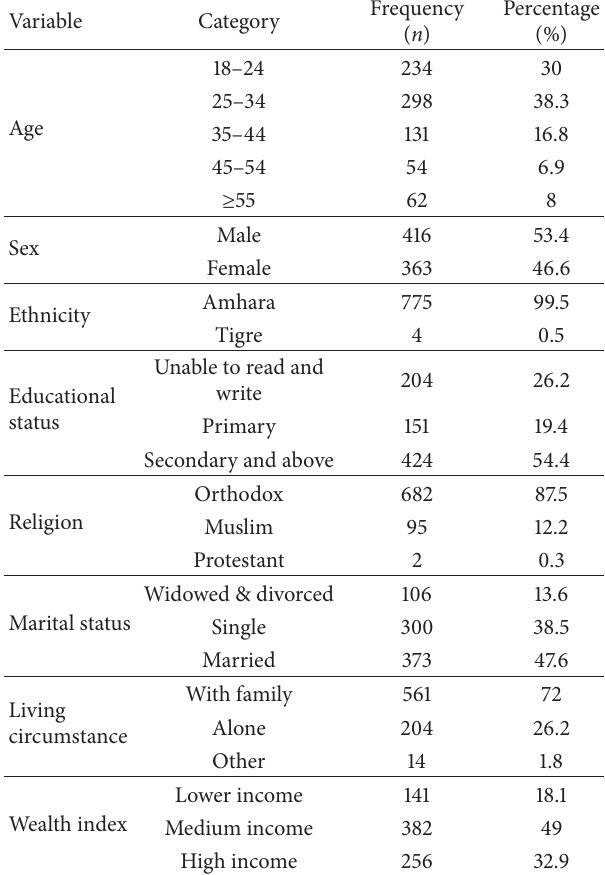
Table 1: Sociodemographic characteristics of respondents in Ebinat town, Northwest Ethiopia,